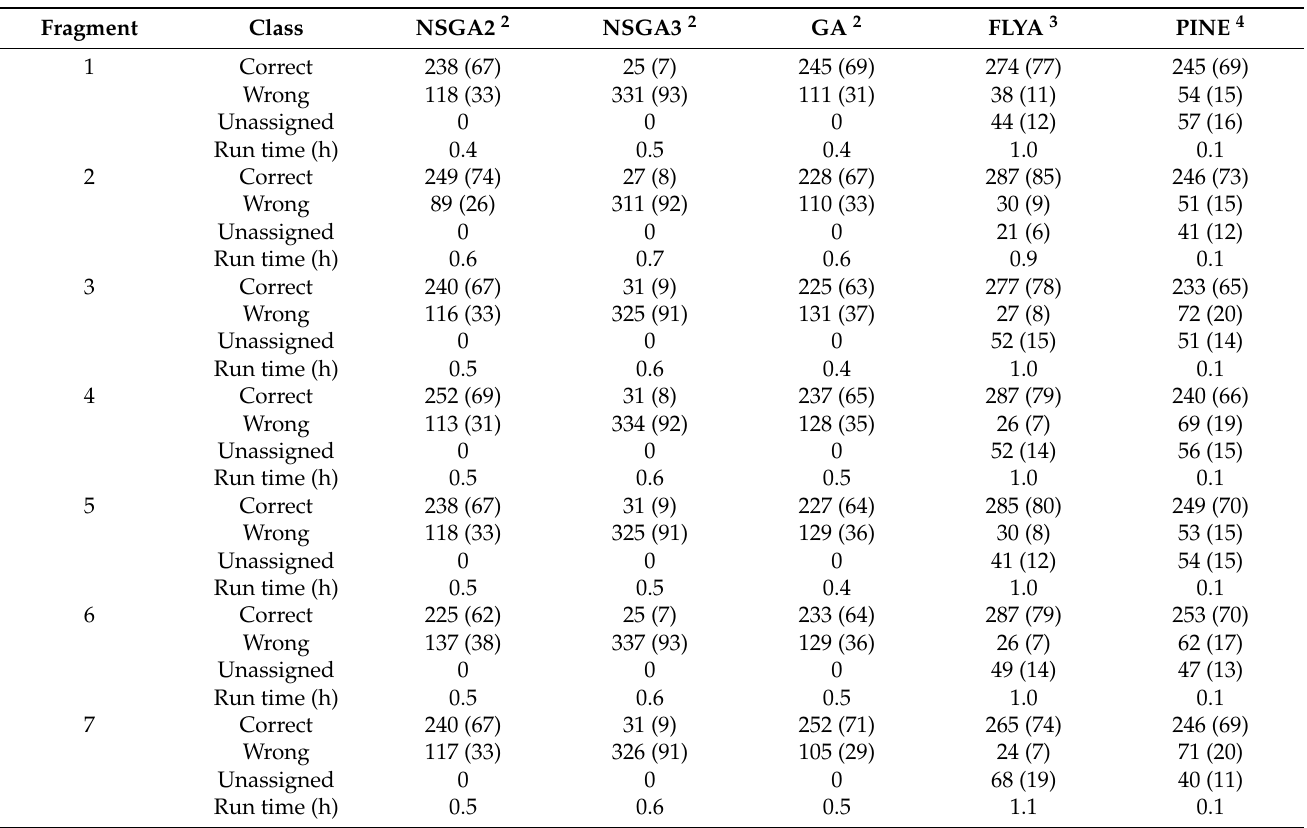
Table 2. Chemical shift assignment results for Fes SH2.